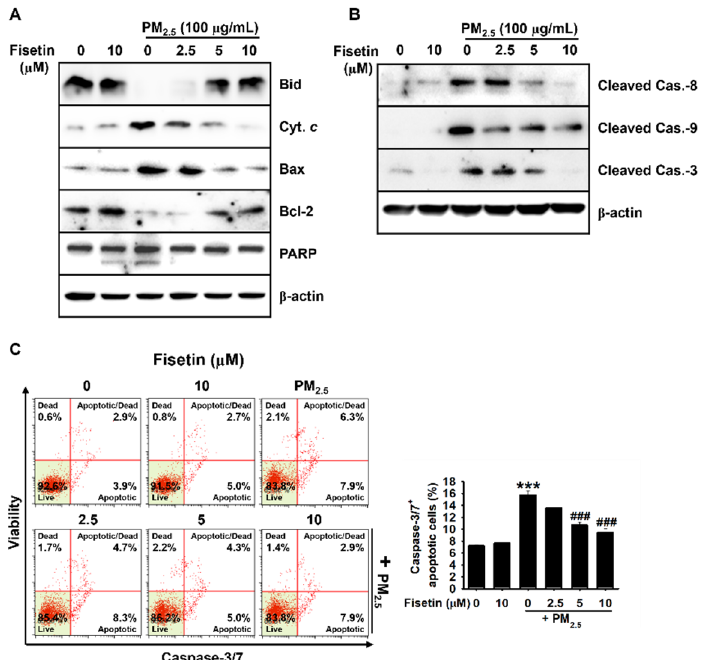
Figure 2. Fisetin downregulates PM 2.5 -induced pro-apoptotic activity in HaCaT keratinocytes. The HaCaT keratinocytes were treated with fisetin (0–10 µ M) for 2 h prior to exposure to 100 µ g/mL PM 2.5 for 24 h. The total proteins were extracted, and Western blotting was performed for detecting the expression of ( A ) Bid, cytochrome c (Cyt. c ), Bax, Bcl-2, and PARP; and ( B ) cleaved caspase (Cas.)-8, Cas.-9, and Cas.-3. β -Actin was used as the loading control. ( C ) The population of caspase-3/7 + apoptotic cells was measured using a Muse Caspase-3/7 Assay Kit. Graphical representation of the population of early/late apoptotic cells ( right ). *** p < 0.001 vs. untreated cells and ### p < 0.001 vs. PM 2.5 -treated